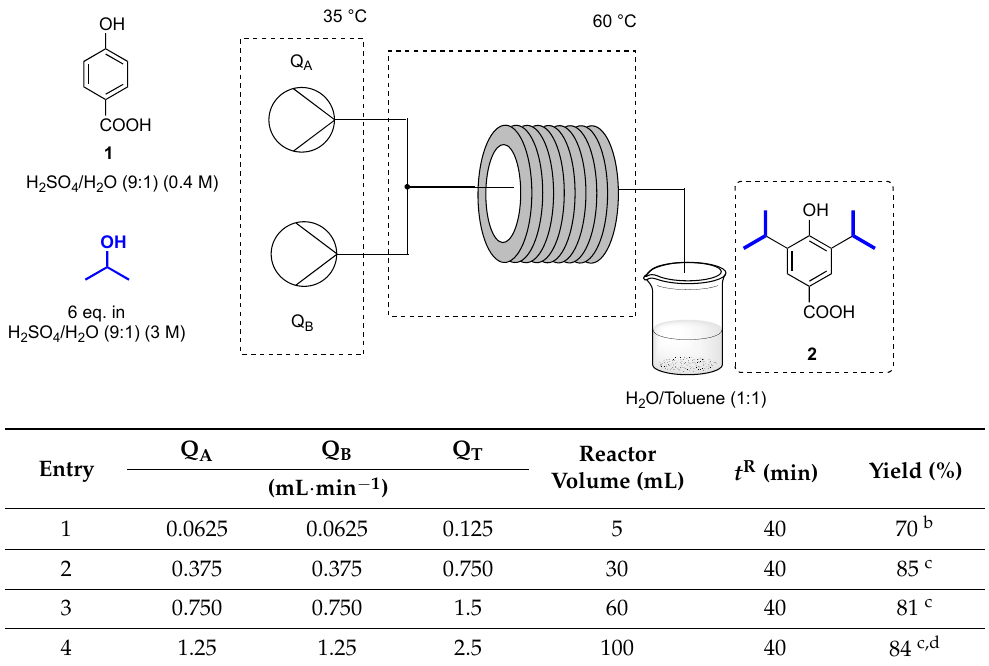
Table 1. Synthesis of compound 2 in a flow system a .